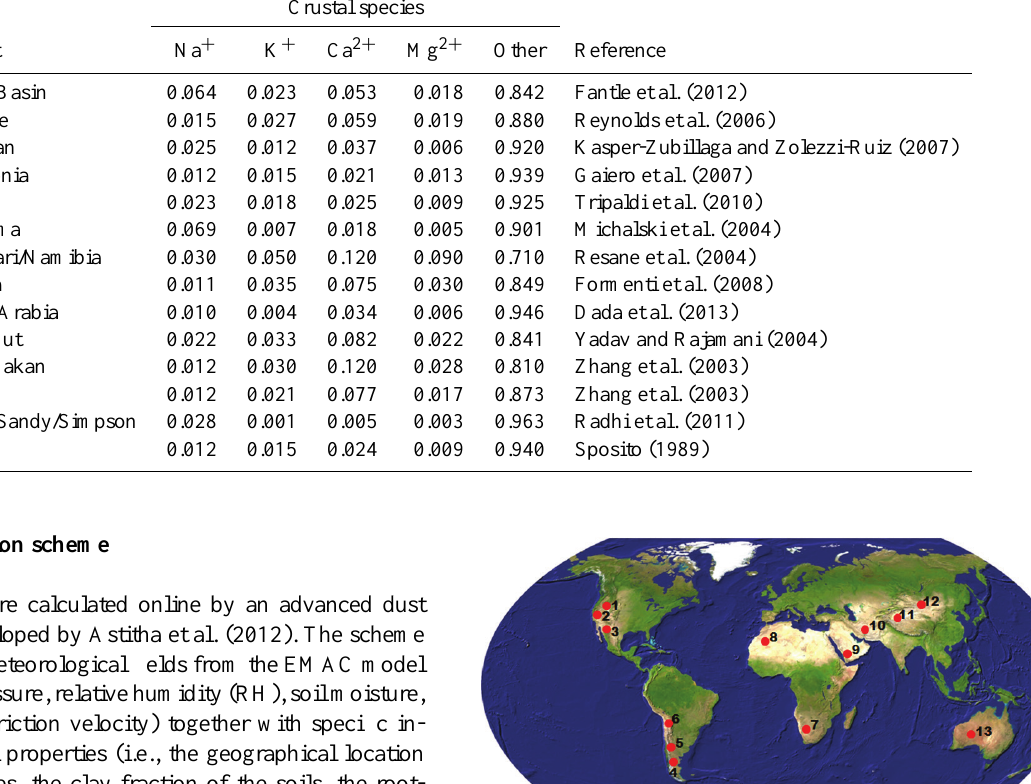
Crustal species